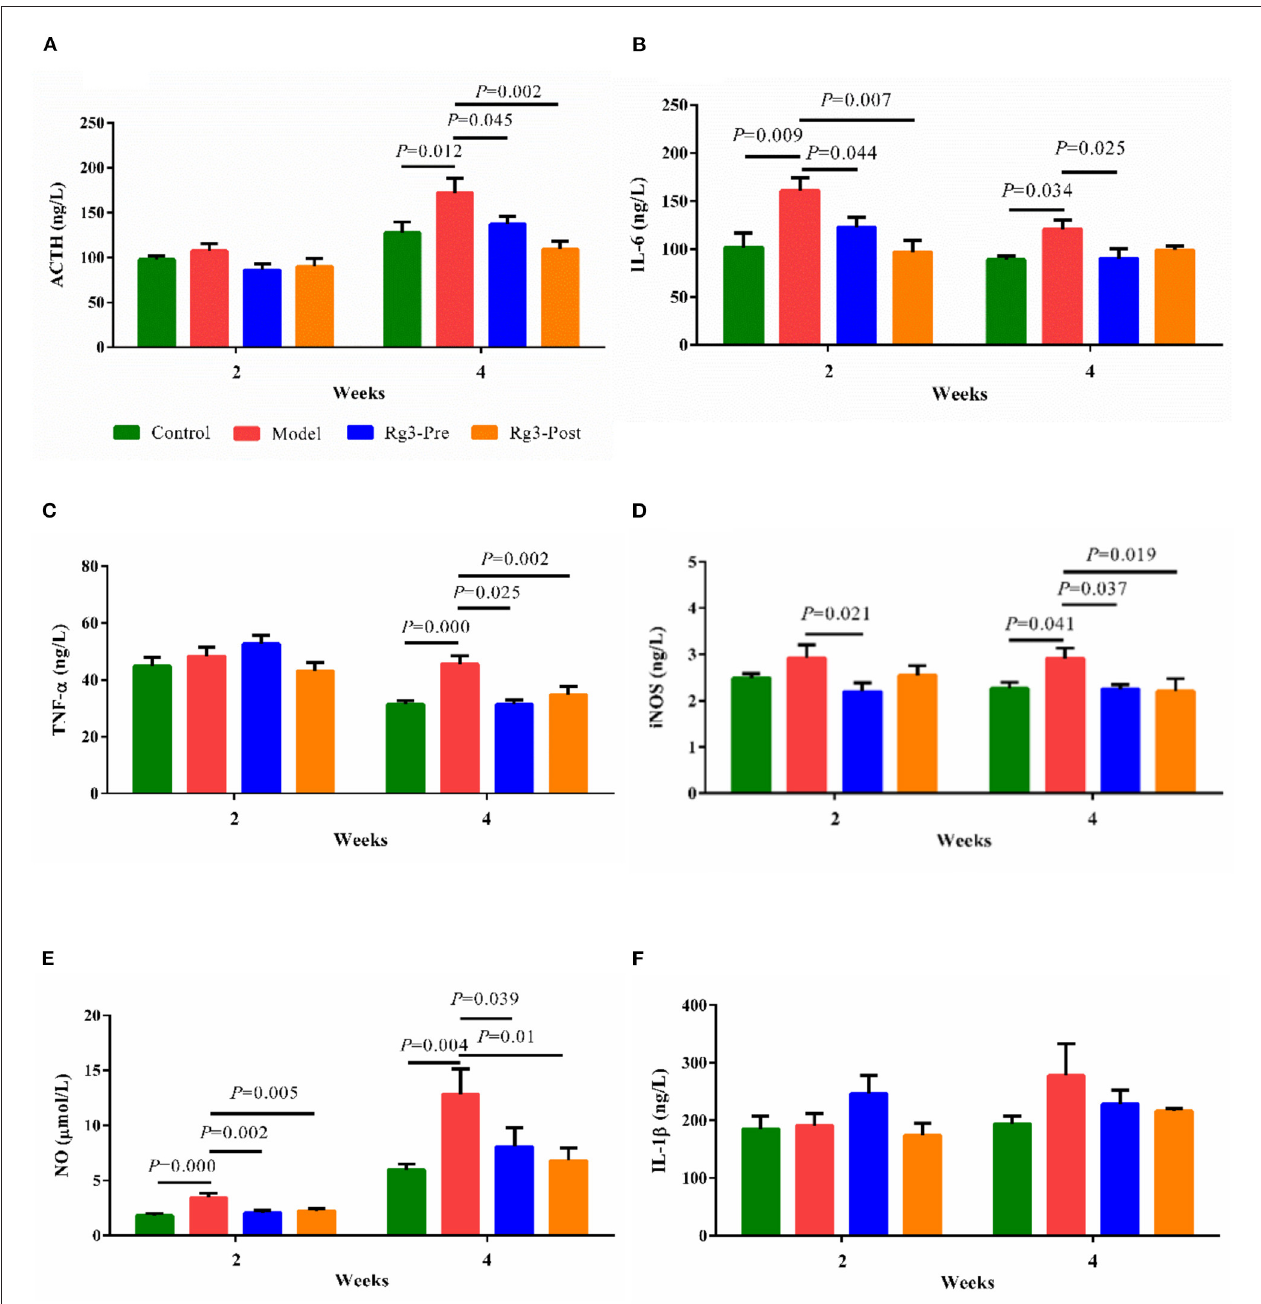
FIGURE 3 | Effect of ginsenoside Rg3 on adrenocorticotropic hormone (ACTH) and inflammatory responses in serum of broilers with stress. Determination of serum ACTH (A) , interleukin-6 (IL-6) (B) , tumor necrosis factor α (TNF- α ) (C) , inducible nitric oxide synthase (iNOS) (D) , nitric oxide (NO) (E) , and interleukin-1 β (IL-1 β ) (F) by ELISA. The values are represented as means ± SE ( n =